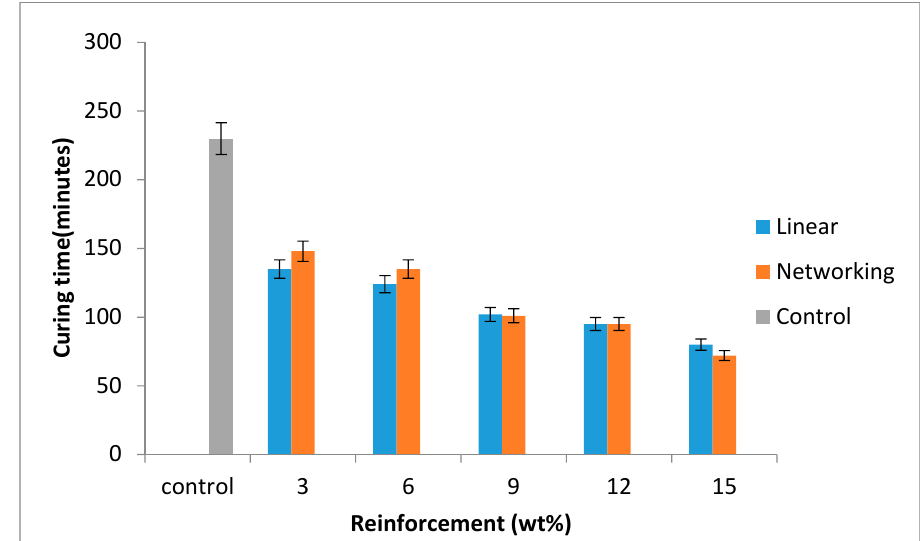
Figure 7. Variation of curing time (minutes) with wt% of reinforcement for the composites and the control sample.